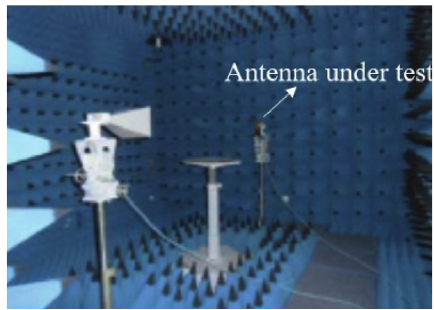
Figure 12: Photograph of the antenna measurement